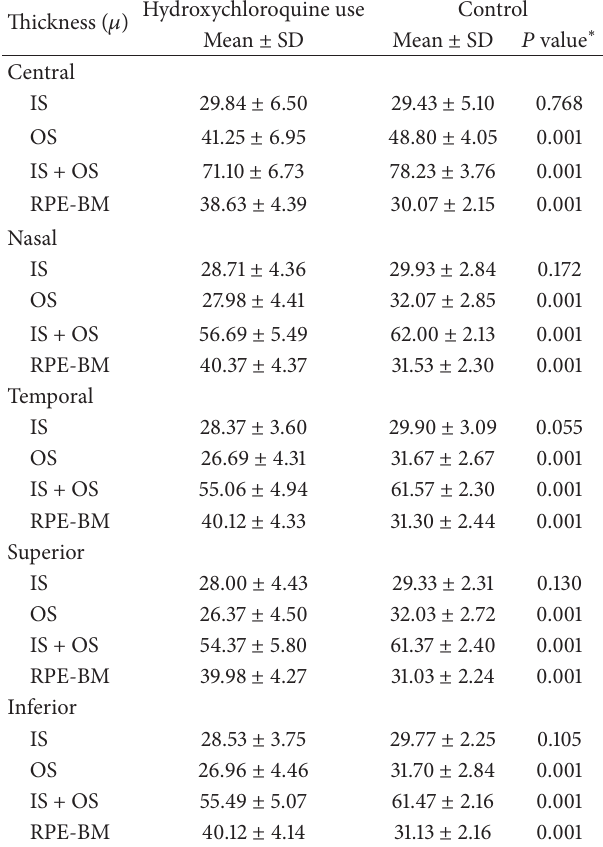
Table 2: Comparison of SD-OCT image segmentation values in hydroxychloroquine use and controls.